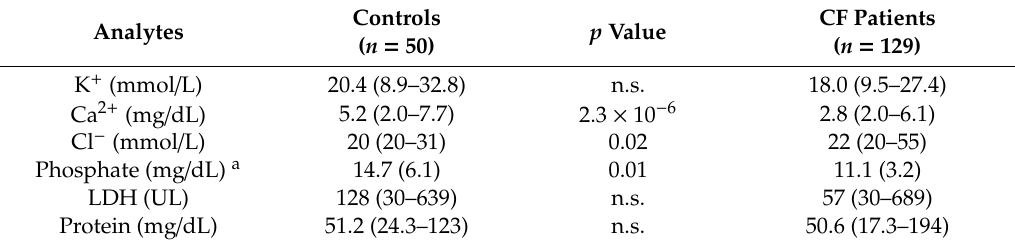
Table 2. Salivary biochemical parameters in control subjects and in adult patients with